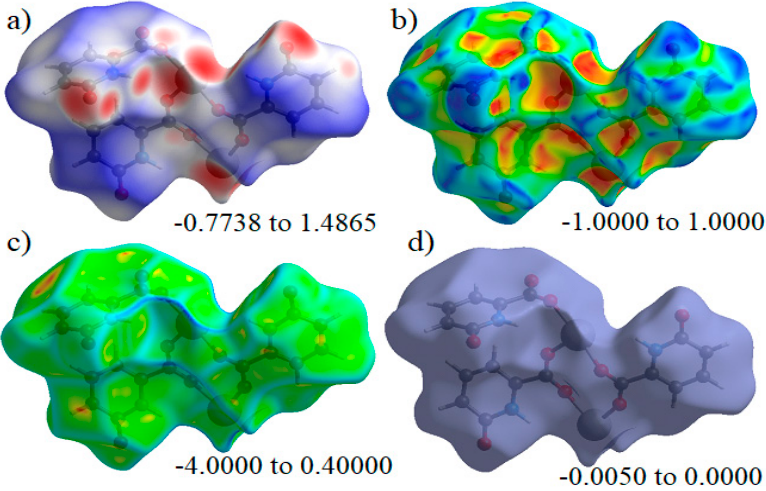
Figure 4. Hirshfeld surfaces mapped with ( a ) d norm, ( b ) shape index, ( c ) curvedness, and ( d ) fragment patch for compound 1 .